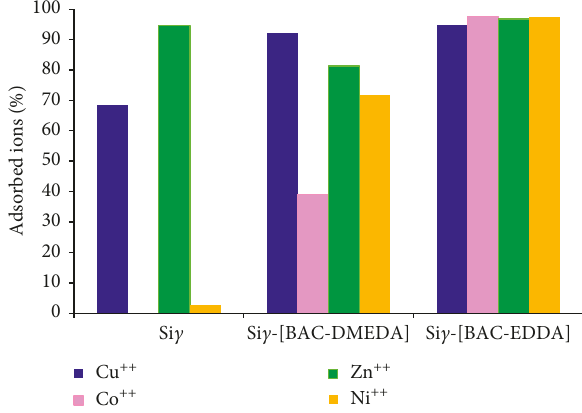
Figure 7: Adsorption (%) on Si c , Si c -[BAC-DMEDA], and Si c -[BAC-EDDA] from a solution of mixed metal ions. Table 5: Starting mixture concentration, residual concentration, and percent adsorption of heavy metal ions after elution on Si c , Si c -[BAC- DMEDA], and Si c